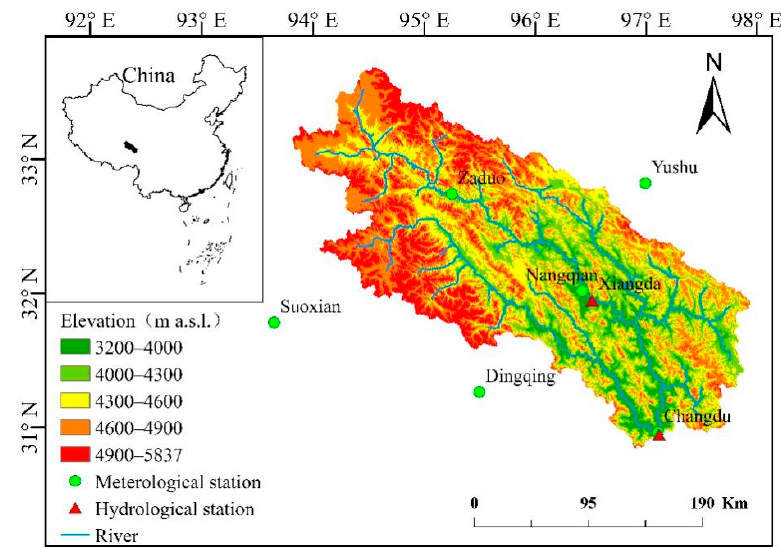
Figure 1. Location of the research basin and spatial distribution of the stations.